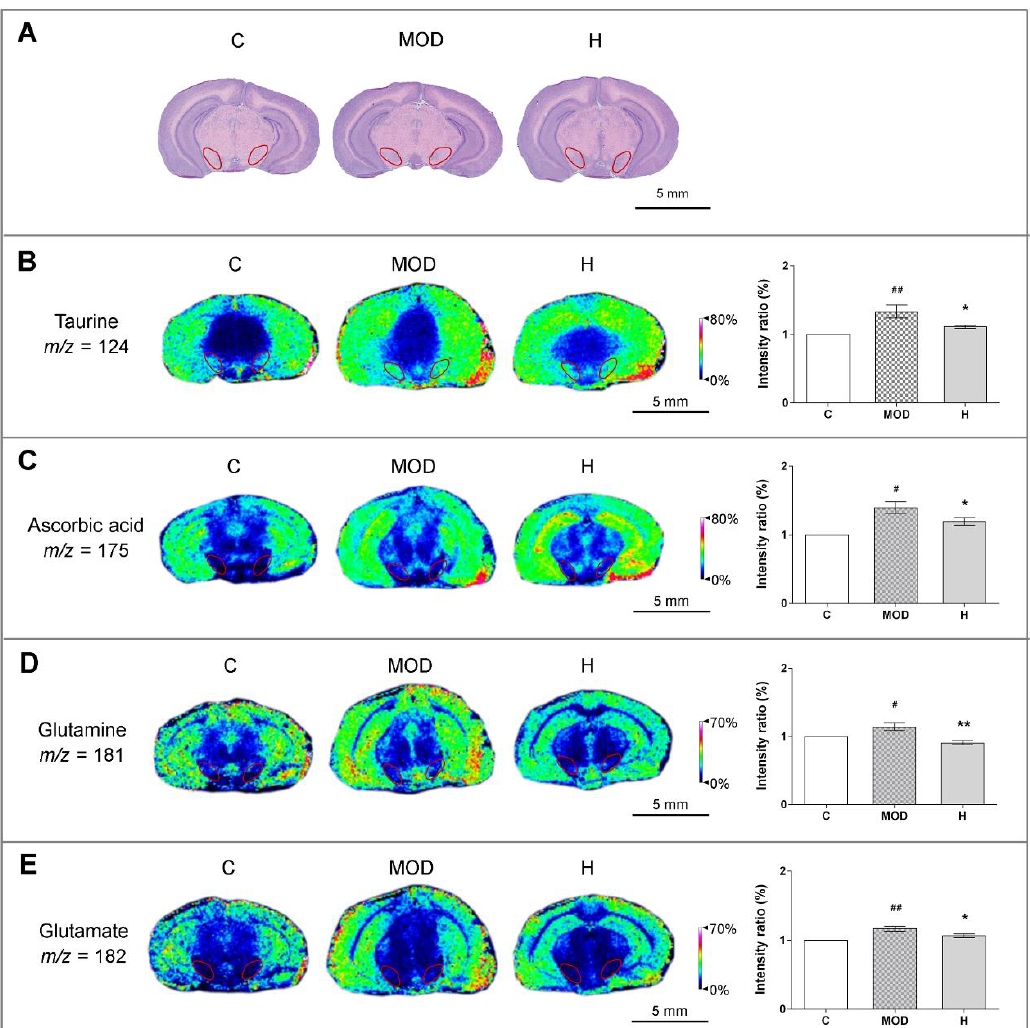
Figure 3. Icaritin attenuates the levels of antioxidant molecules in the substantia nigra of mice in the MPTP model of PD. ( A ) Hematoxylin/eosin staining of adjacent brain sections, and substantia nigra is marked by red circles, the position of which was − 3.28 mm away from the bregma and 0.52 mm away from in-teraural midpoint in mice. ( B – E ) In situ matrix-assisted laser desorption/ionization–mass spectrometry imaging (MALDI–MSI) of taurine, ascorbic acid, glutamine, and glutamate. Spatial resolution: 200 µ m; scale bar: 5 mm; m / z : mass-to-charge ratio. C: control; MOD: PD model; H: 18.9 mg/kg icaritin. Data are presented as means ± SEM; n = 3 per group. # p < 0.05, ## p < 0.01 vs. S group; * p < 0.05, ** p < 0.01 vs. MOD group.